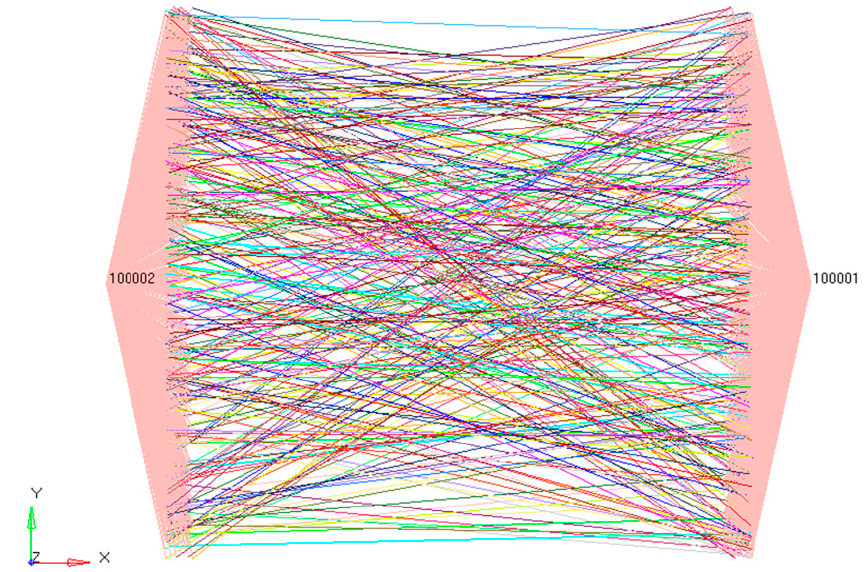
Figure 14. Finite element loading diagram of nanofibrous mats.